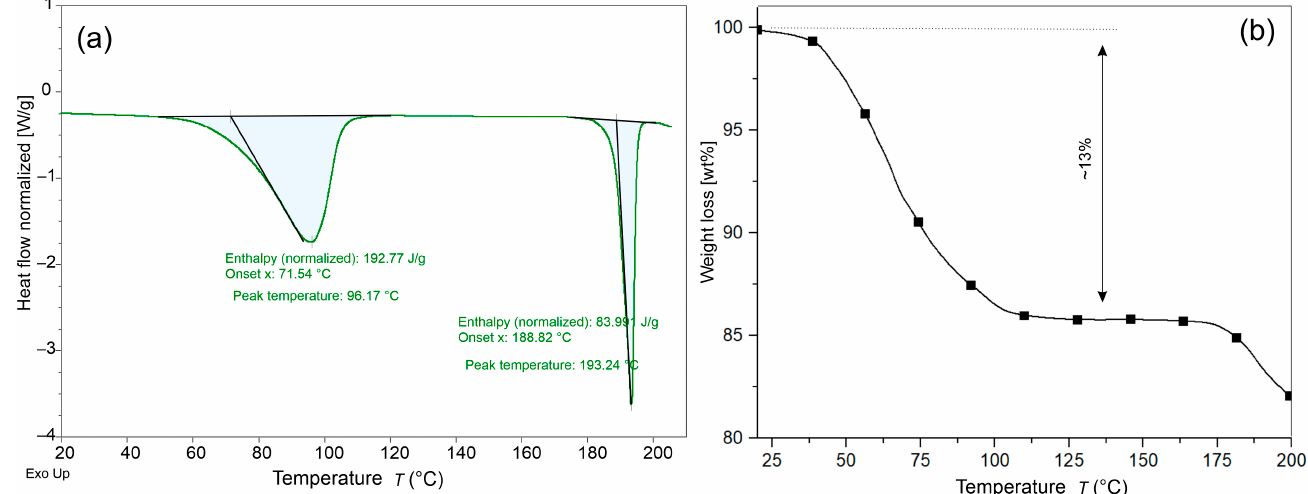
Figure 2. Thermal analysis of the title compound. ( a ) DSC thermogram of the title compound disclosing two endothermic effects associated with the release of methanol (60–110 °C) and ( b ) TGA data reveling a weight loss of ~13% corresponding to methanol molecule.